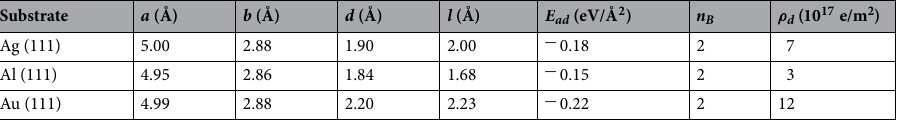
Table 1. Structural properties of the substrate-supported bilayer β 12 borophenes: lattice constants ( a and b ), interlayer distance ( d ), substrate-overlayer distance ( l ), substrate adhesion energy ( E ad ), number of covalent bonds per unit cell ( n B ), and density of electrons donated from the substrate ( ρ d ).